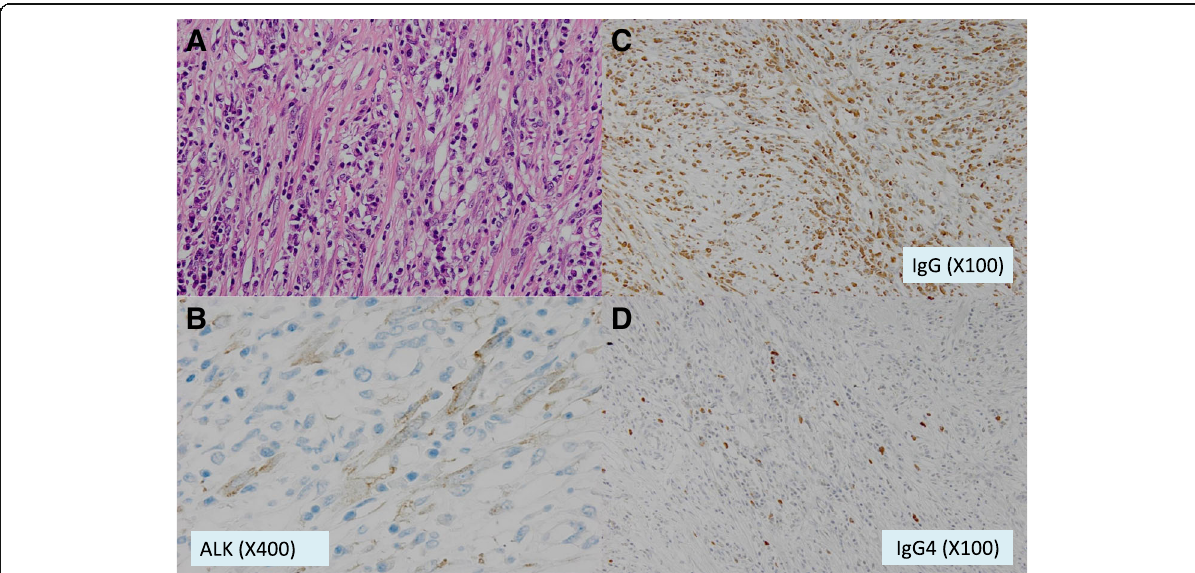
Fig. 2 a Histopathological examination demonstrated proliferation of spindle cells and collagen fiber, and the infiltration of plasma cells and lymphocytes (× 100). b ALK expression was positive in the spindle cells (× 400). c There were a lot of IgG-positive plasma cells (× 100). d On the other hand, few cells were positive for IgG4-positive plasma cells (×